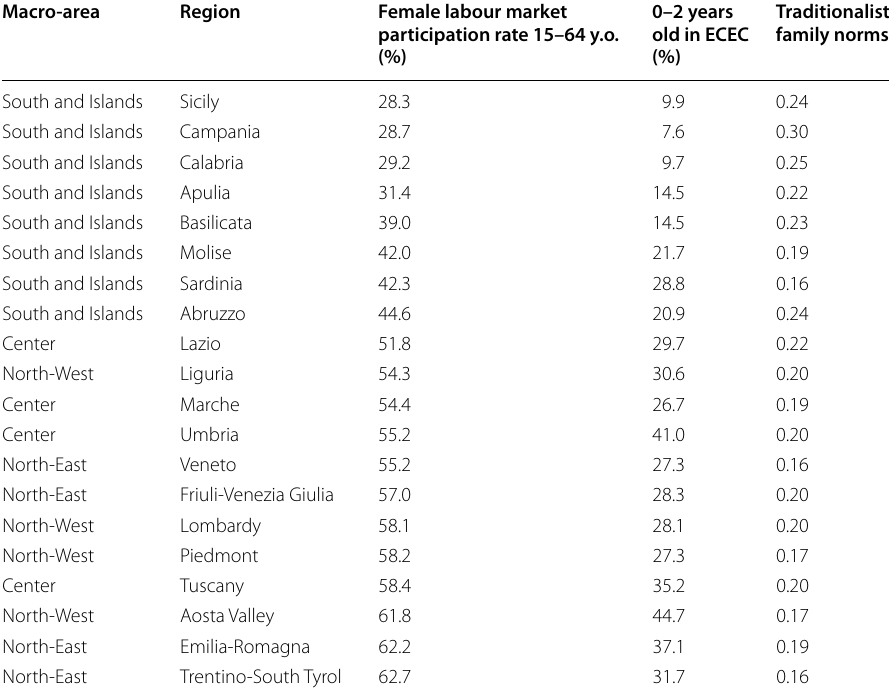
Table 1 Regional-level indicators, Italy,